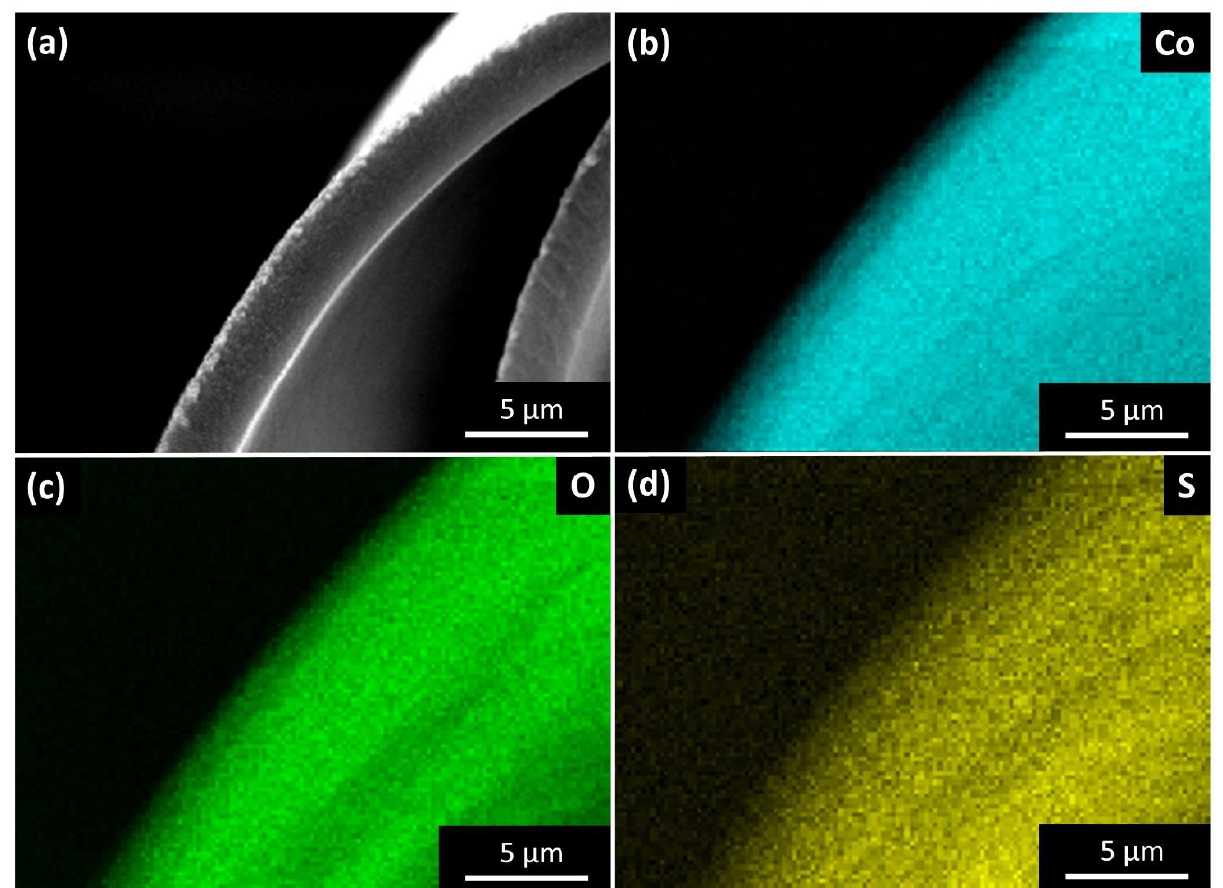
Figure 4. Energy-dispersive X-ray spectroscopy (EDX) mapping of the cross-section of an individual microscroll. ( a ) Corresponding SEM image of the analyzed microscroll. ( b – d ) Elemental distribution of ( b ) cobalt, ( c ) oxygen, and ( d ) sulfur. Homogenous distribution patterns are observed for both cobalt and oxygen, representing the major elements of the mineral structure, as well as sulfur, indicating a uniform incorporation of PSS as a minority component throughout the film.